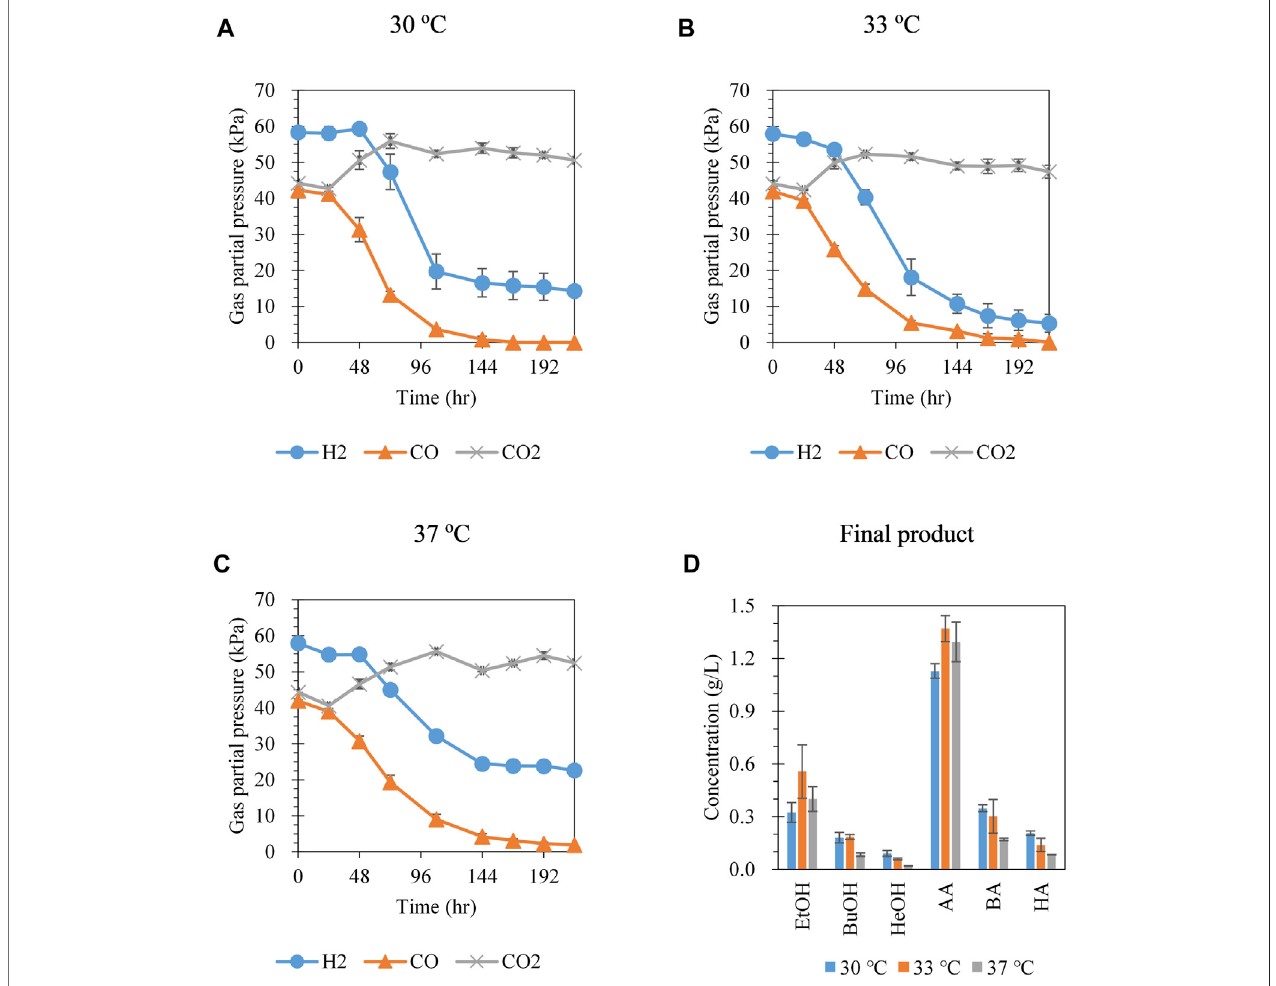
FIGURE 1 | Gas pressure pro fi les at (A) 30 ° C, (B) 33 ° C, and (C) 37 ° C and (D) metabolite concentration at 216 h from syngas fermentation by C. carboxidivorans P7. The headspace was fi lled with syngas CO:CO 2 :H 2 = 30:30:40 at an initial headspace pressure of 150 kPa. Each data point and error bar represent the average and range of duplicate experiments, respectively. EtOH, ethanol; BuOH, butanol; HeOH, hexanol; AA, acetic acid; BA, butyric acid; HA, hexanoic